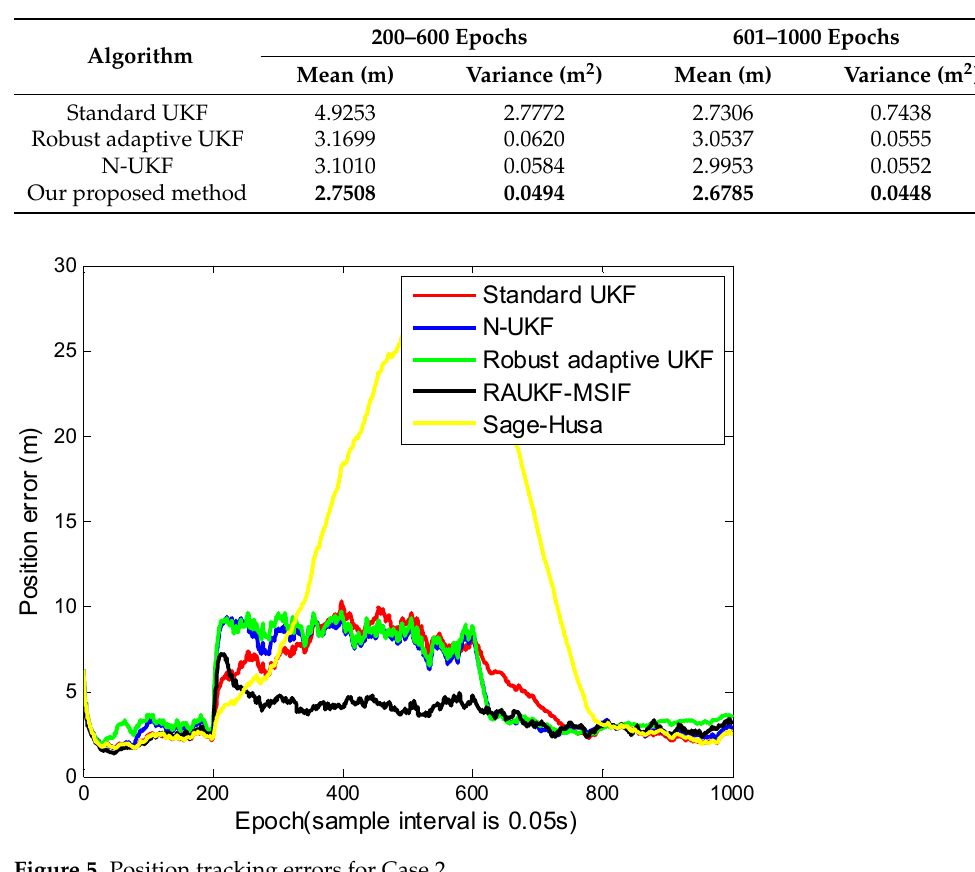
Figure 5. Position tracking errors for Case 2.